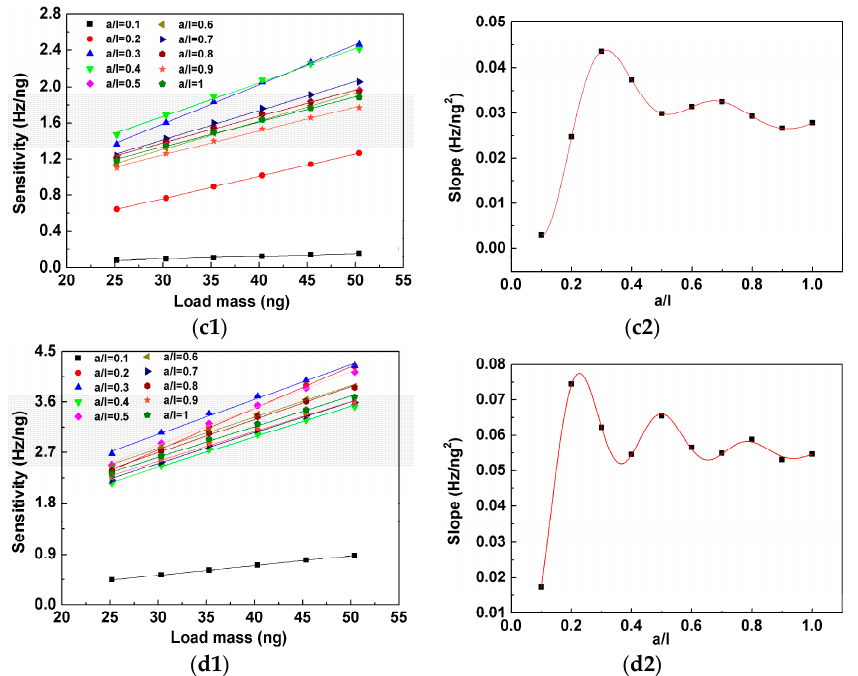
Figure 7. Sensitivity of the cantilever as a function of load mass under ( a1 ) first-order resonance, ( b1 ) second-order resonance, ( c1 ) third-order resonance, and ( d1 ) fourth-order resonance. All the data points are fitted by linear functions and the slopes of the linear fittings as a function of a / l are shown in Figure 7( a2 , b2 , c2 , d2 ).